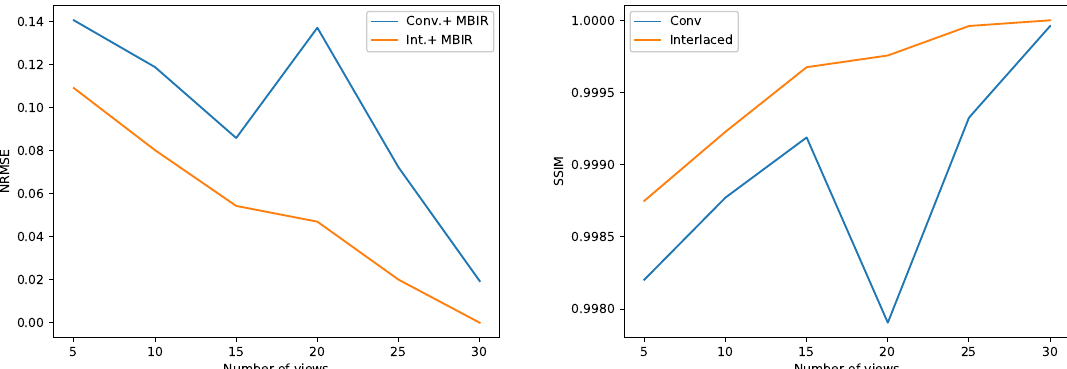
Figure 5. Comparison of normalized root mean squared error (NRMSE) and structural-similarity (SSIM) metrics between the current reconstruction and the final reconstruction in Figure 4 using the MBIR algorithm. Notice that the SSIM and NRMSE converge faster for the interlaced scanning approach compared to the conventional scanning protocol.